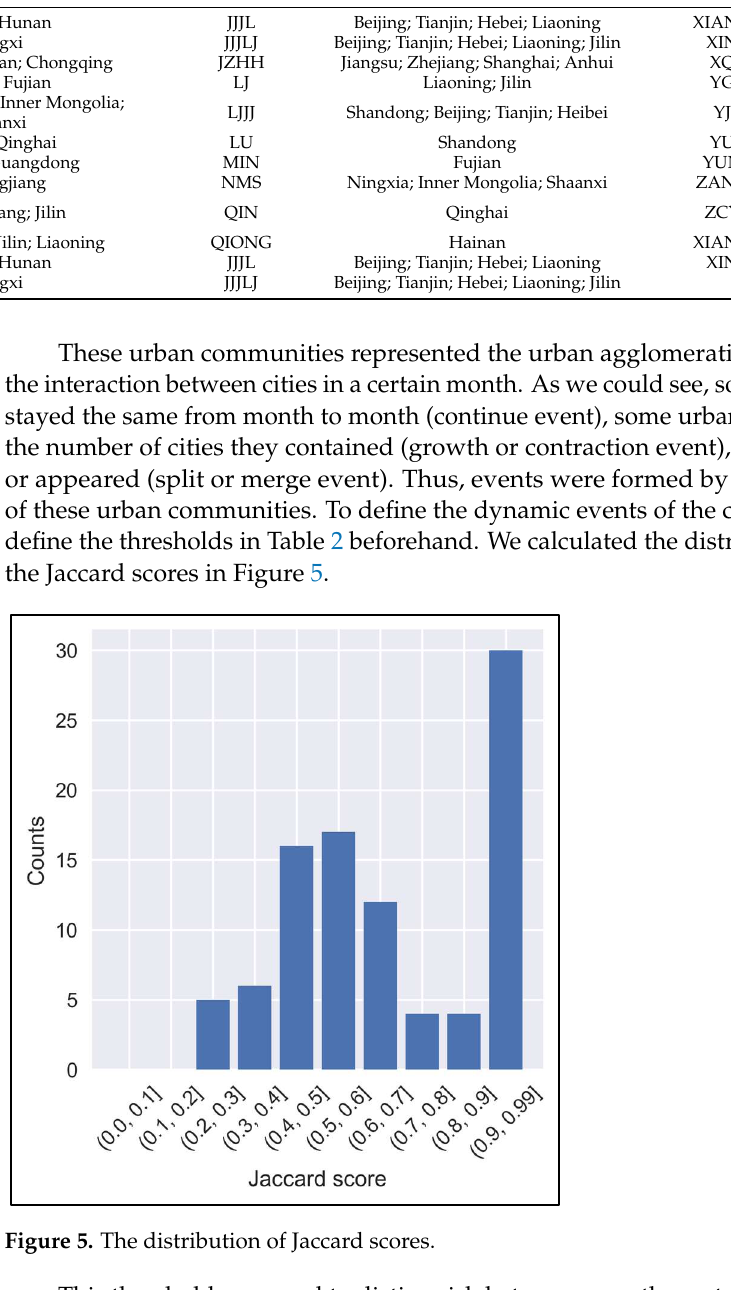
Figure 6. The numbers of five dynamic events in each period. In this figure, the vertical axis shows the number of events that occurred. The hori- zontal axis shows the period in which they happened (e.g., 2020/11 means the period from October to November 2020). From Figure 6, we obtained an overview of the dy- namics of these urban interactions. Continuous events dominated over all periods, but other events still existed in each period, which indicated that the inter-monthly dynamic of interactions in most cities was stable, and only a few cities changed their interaction